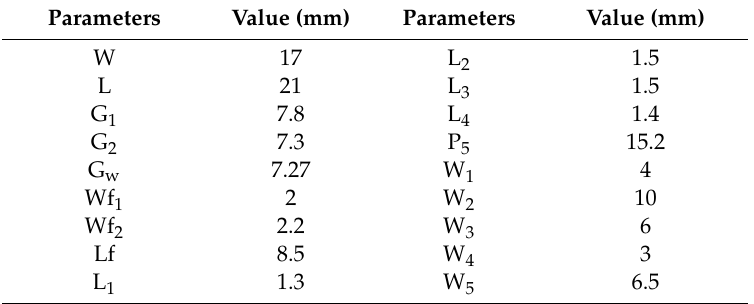
Table 1. The dimension related parameters of the proposed CPW antenna used in the simulation design. Parameters